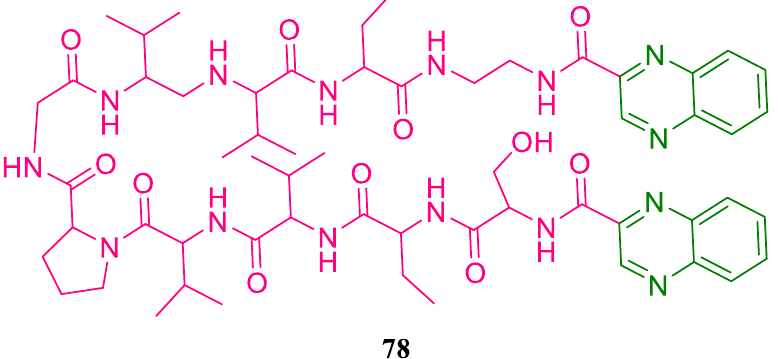
Figure 64. Quinoxaline conjugated to